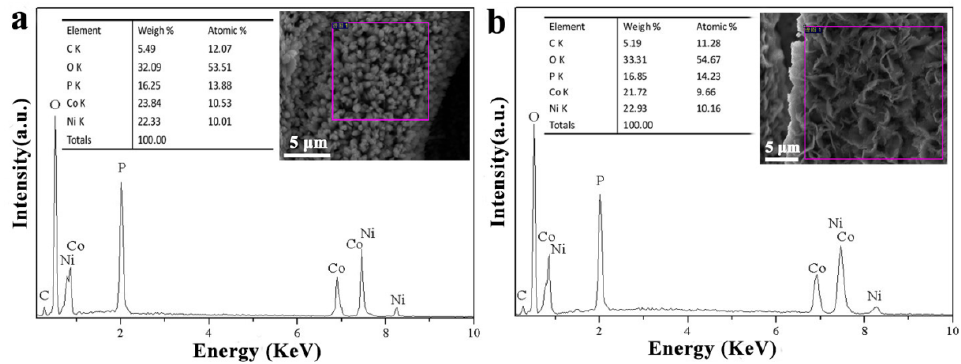
Figure 3. EDS curves of ( a ) MHP bouquet arrays/ACF (inset figure is the selected area for EDS characterization); ( b ) MHP nano-sheet arrays/ACF (inset figure is the selected area for EDS charac- terization).